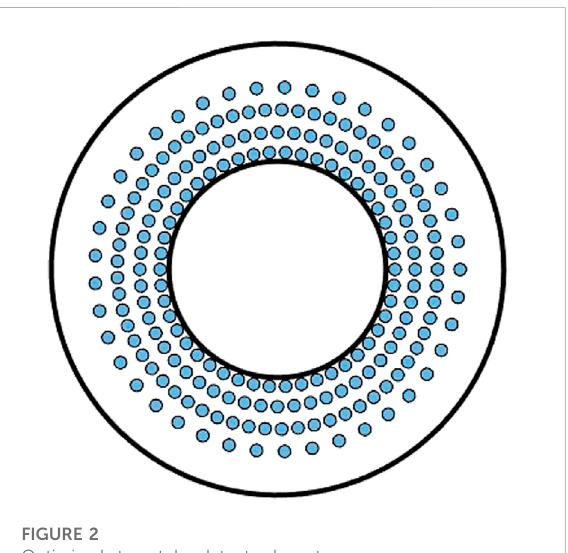
FIGURE 2 Optimized straw tube detector